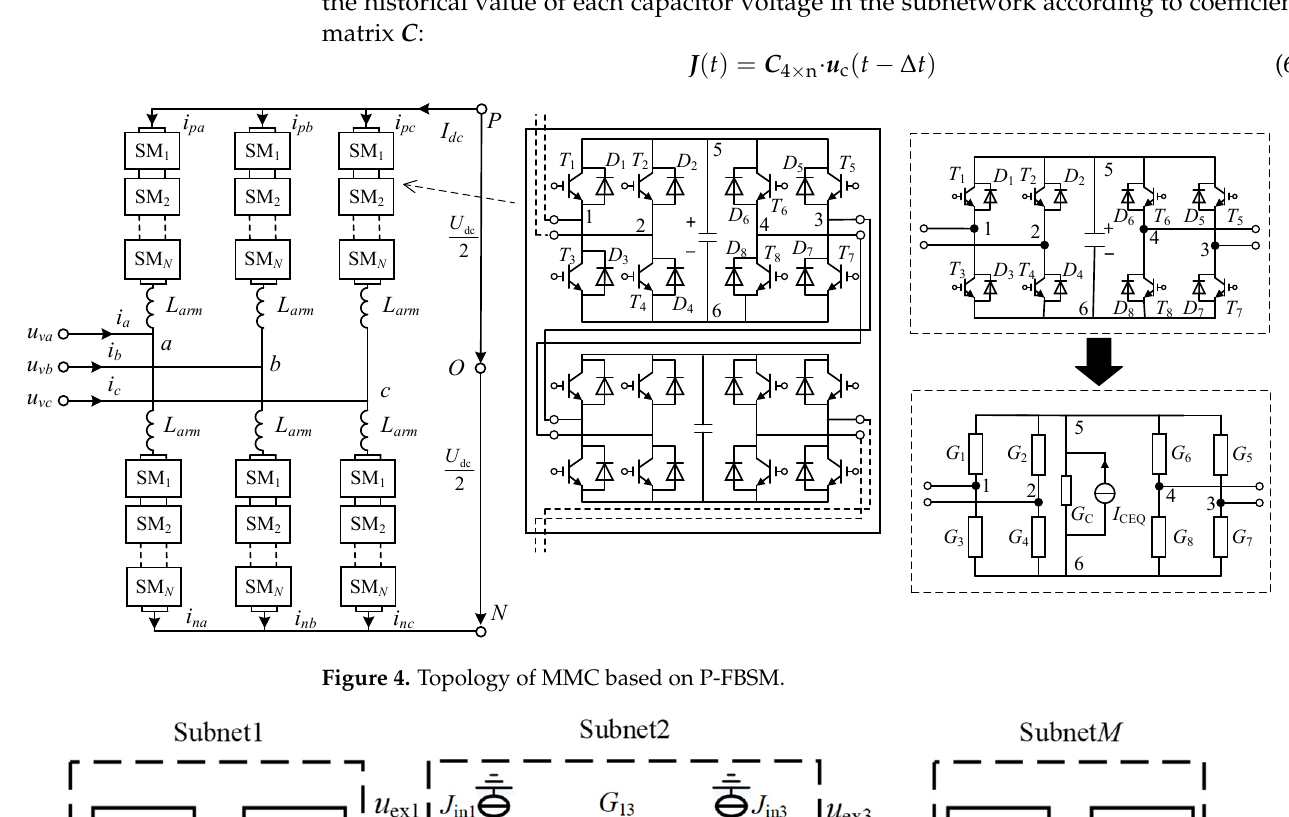
Figure 4. Topology of MMC based on P ‐ FBSM.